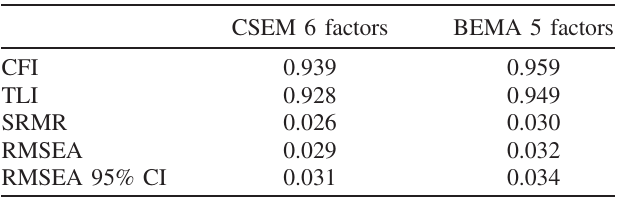
TABLE IV. CFA fit statistics for the two models found through EFA for the CSEM and BEMA. The CSEM was fit using the half of the data set aside for CFA, and the BEMA was fit back against the sample that originated the EFA